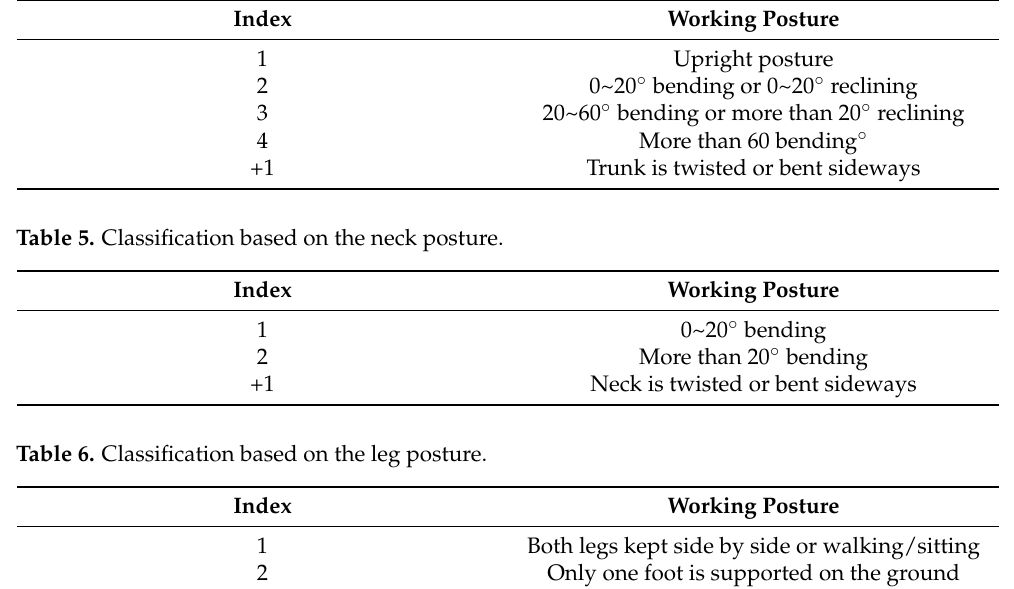
Table 4. Classification based on the body posture.